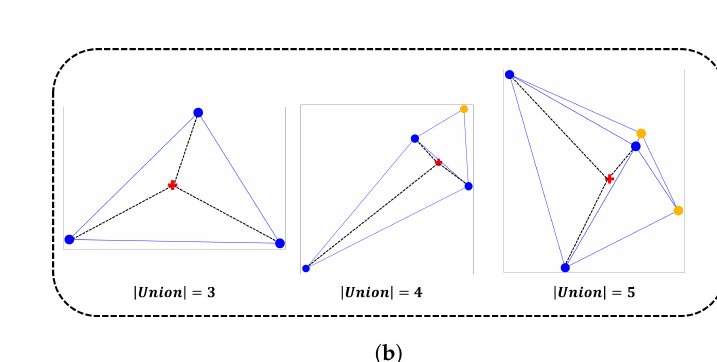
Figure 3. Extension of DT to DT+ using union-inner triangles algorithm. ( a ) Union-inner triangles. ( b ) Cases for the union set of DT weather stations and 3 nearest weather stations.